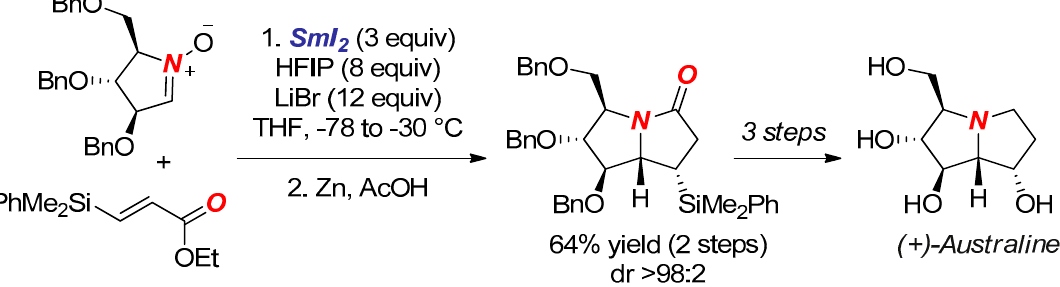
Scheme 9. Synthesis of (+)-Australine by Cross-Coupling Cyclic Nitrones with β -Silyl Acrylates.